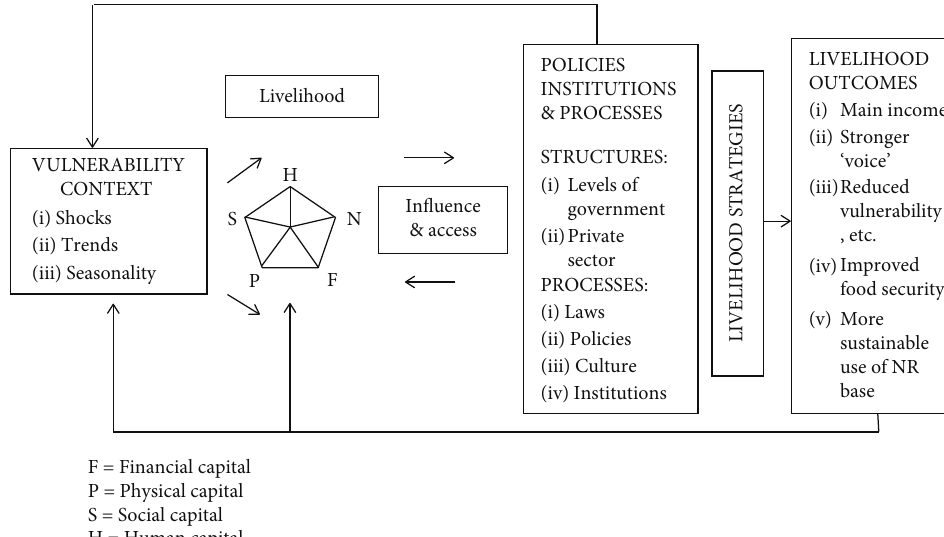
Figure 15: Expectancy livelihood model (ELM) [41].